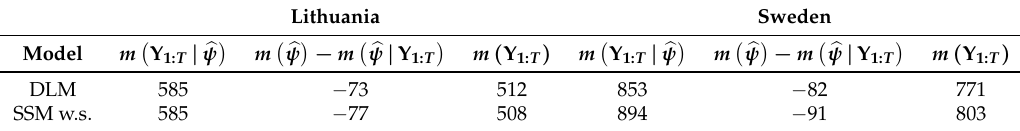
Table 4. Estimates of the marginal log-likelihood for DLM and SSM with switching (SSM